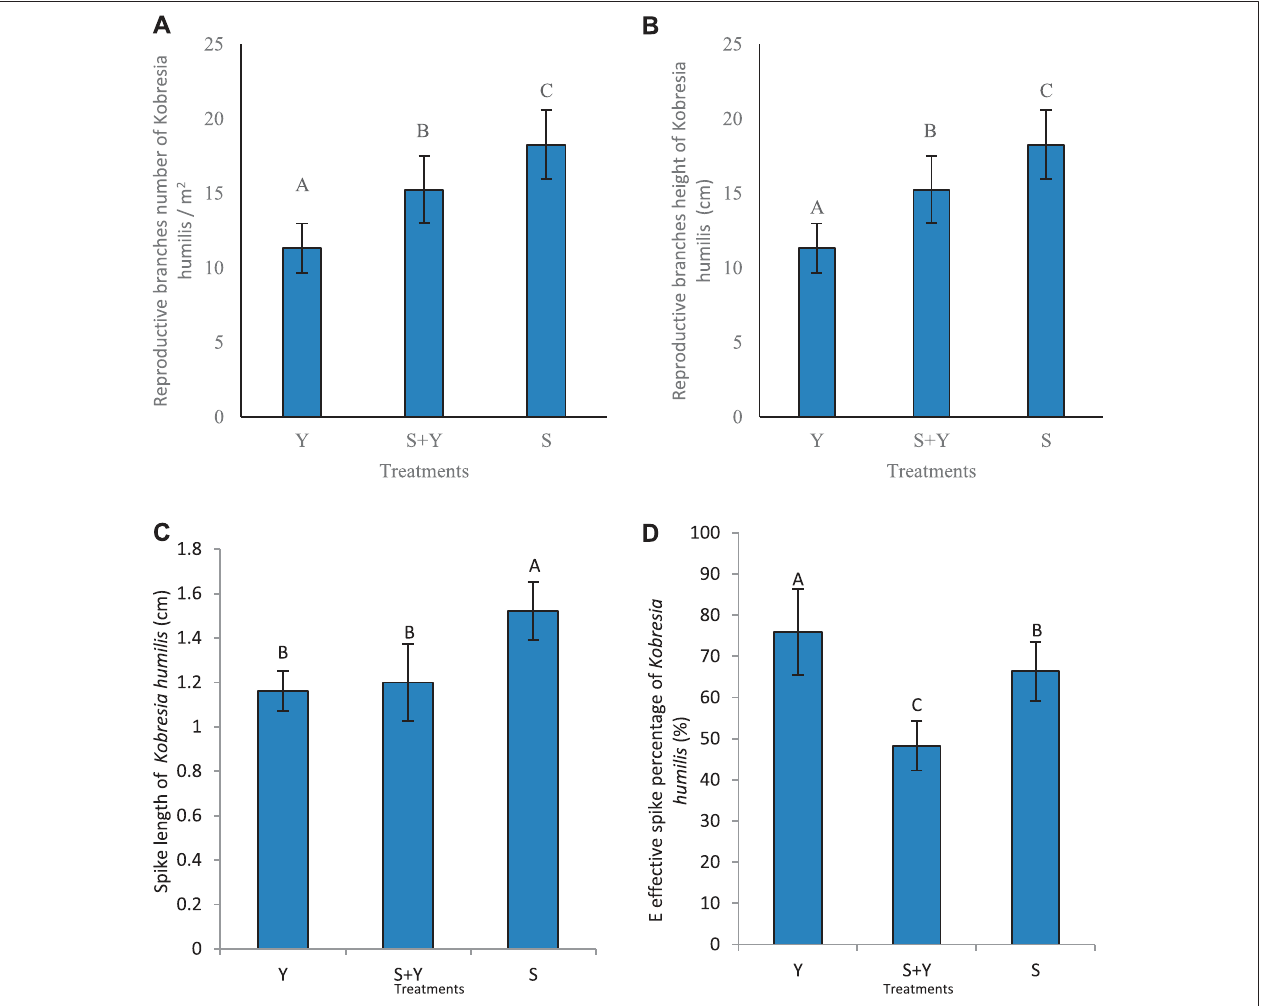
FIGURE 5 | Effects of grazing methods on different sexual reproduction characteristics of K. humilis : (A) reproductive branch density, (B) reproductive branch height, (C) spike length, and (D) effective spike number ratio. Capital letters indicate signi fi cant differences between grazing methods ( p < 0.05).